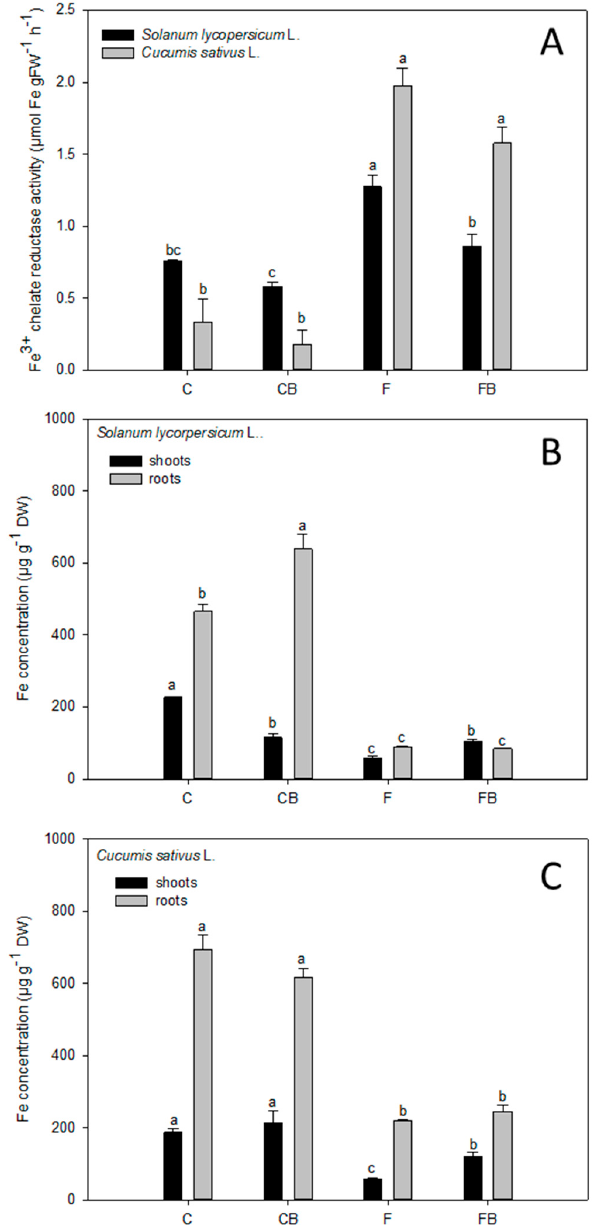
Figure 2. Iron (Fe 3+ )-chelate reductase activity ( A ) in tomato ( Solanum lycopersicum L.) and cucumber ( Cucumis sativus L.) plants grown in either a full nutrient solution supplied without or with the plant-derived protein hydrolysate (C and CB, respectively) or a Fe-deficient nutrient solution without or with the plant-derived protein hydrolysate (F and FB, respectively). Iron concentration of tomato ( B ) and cucumber ( C ) roots and shoots grown in either a full nutrient solution supplied without or with the plant-derived protein hydrolysate (C and CB, respectively) or a Fe-deficient nutrient solution without or with the plant-derived protein hydrolysate (F and FB, respectively). Data are presented as means ± SE ( n = 3). Statistical significance was tested by one-way ANOVA analysis with the Student–Newman–Keuls post hoc test ( p < 0.001). Different letters indicate statistically different values within each plant species.